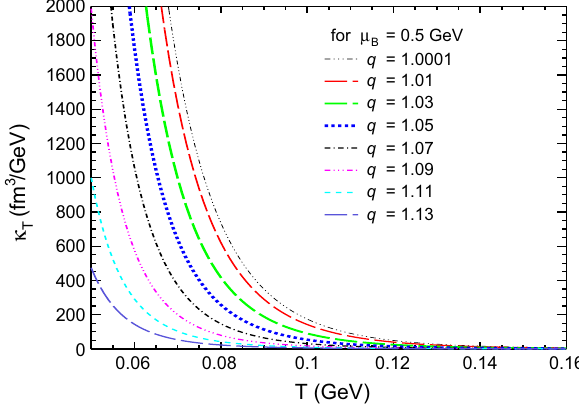
Fig. 10 Speed of sound as a function of temperature for various mass cutoffs, at μ B = 0 . 5